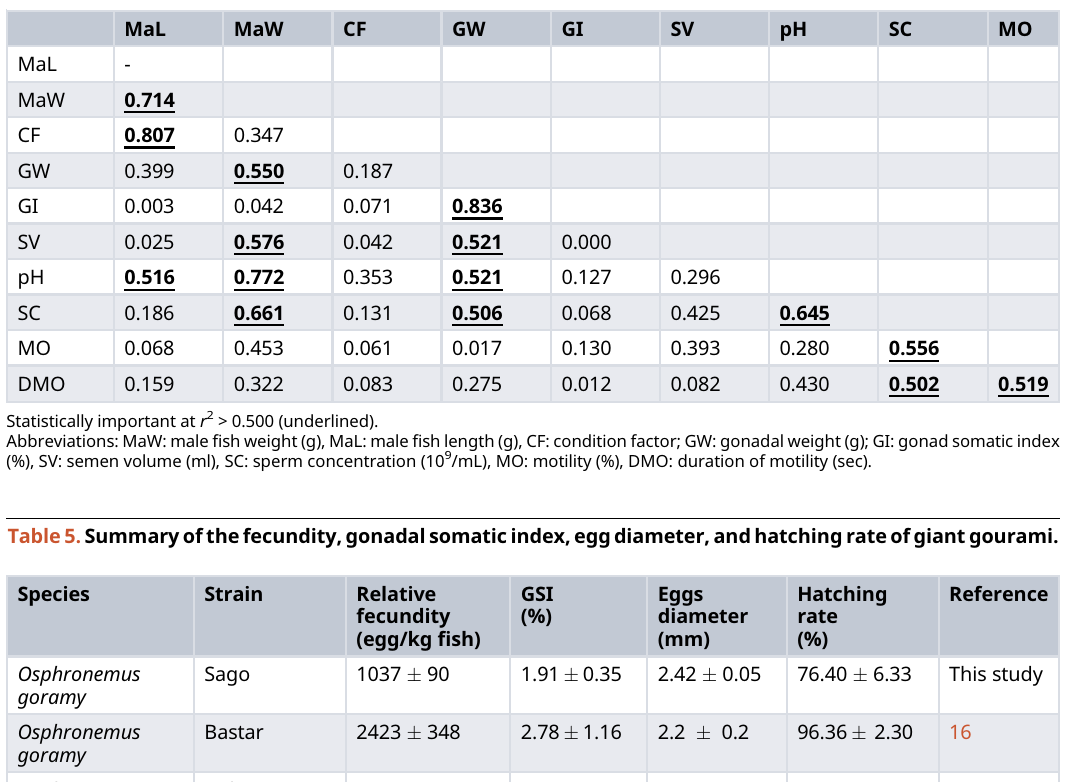
Table 4. Correlations of variables ( r 2 ) in sago strain of giant gourami males broodfish.